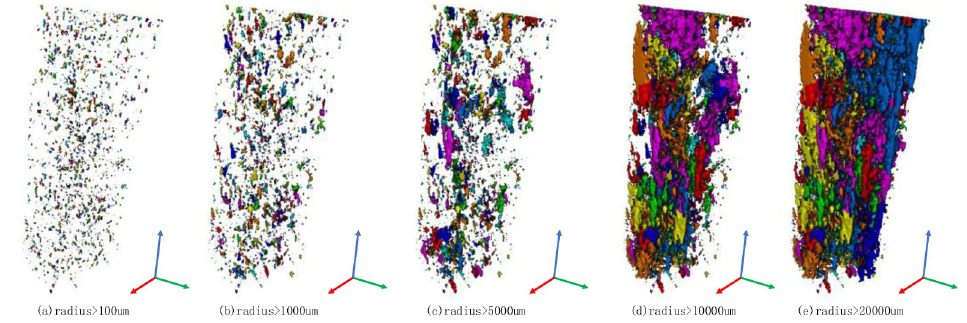
Fig 6. Distribution of pore radius at different scales.